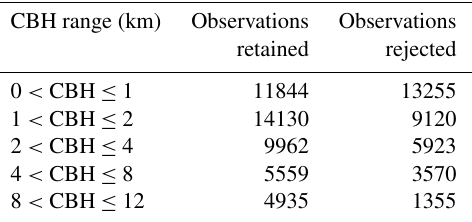
Table 1. Frequency of measurements from the validation data set (30 June to 27 September 2019) per range of cloud base height (CBH) used in the evaluations described in Sect. 4.4 (retained) and frequency of those filtered from the evaluation due to increased vari- ability in the CBH (rejected). CBH range (km) Observations Observations retained rejected 0 < CBH ≤ 1 11844